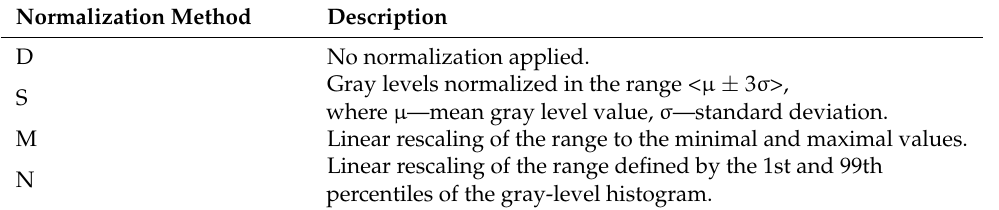
Table 2. Normalization methods accessible in MaZda